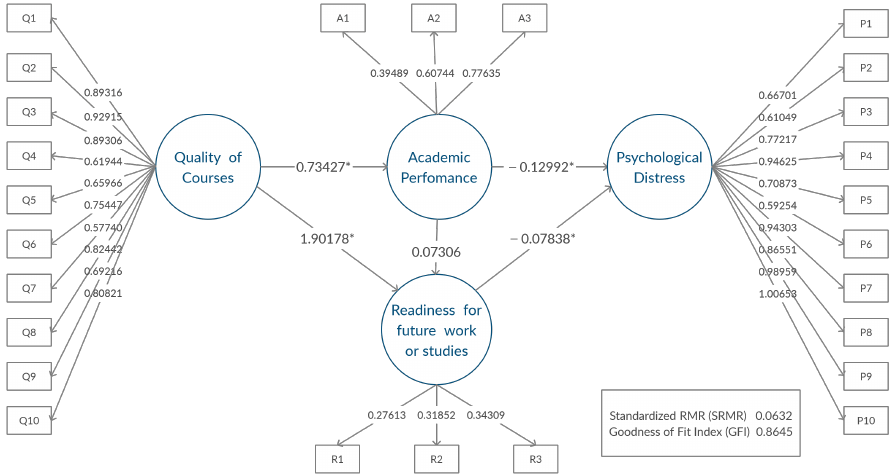
Figure 2. Path model for females, * significant relationship between latent factors.